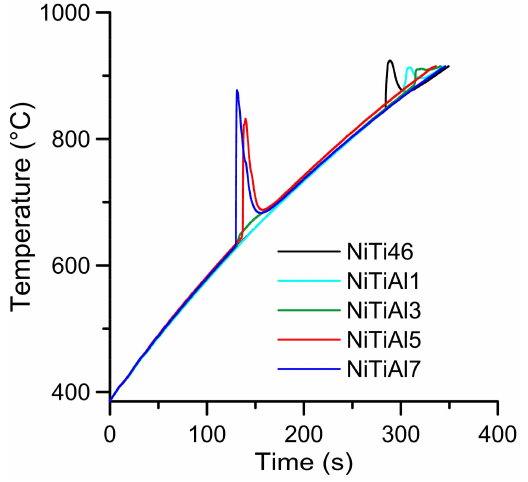
Figure 4. Heating curves of NiTi46 and NiTiAl1–7, recorded by optical pyrometer.